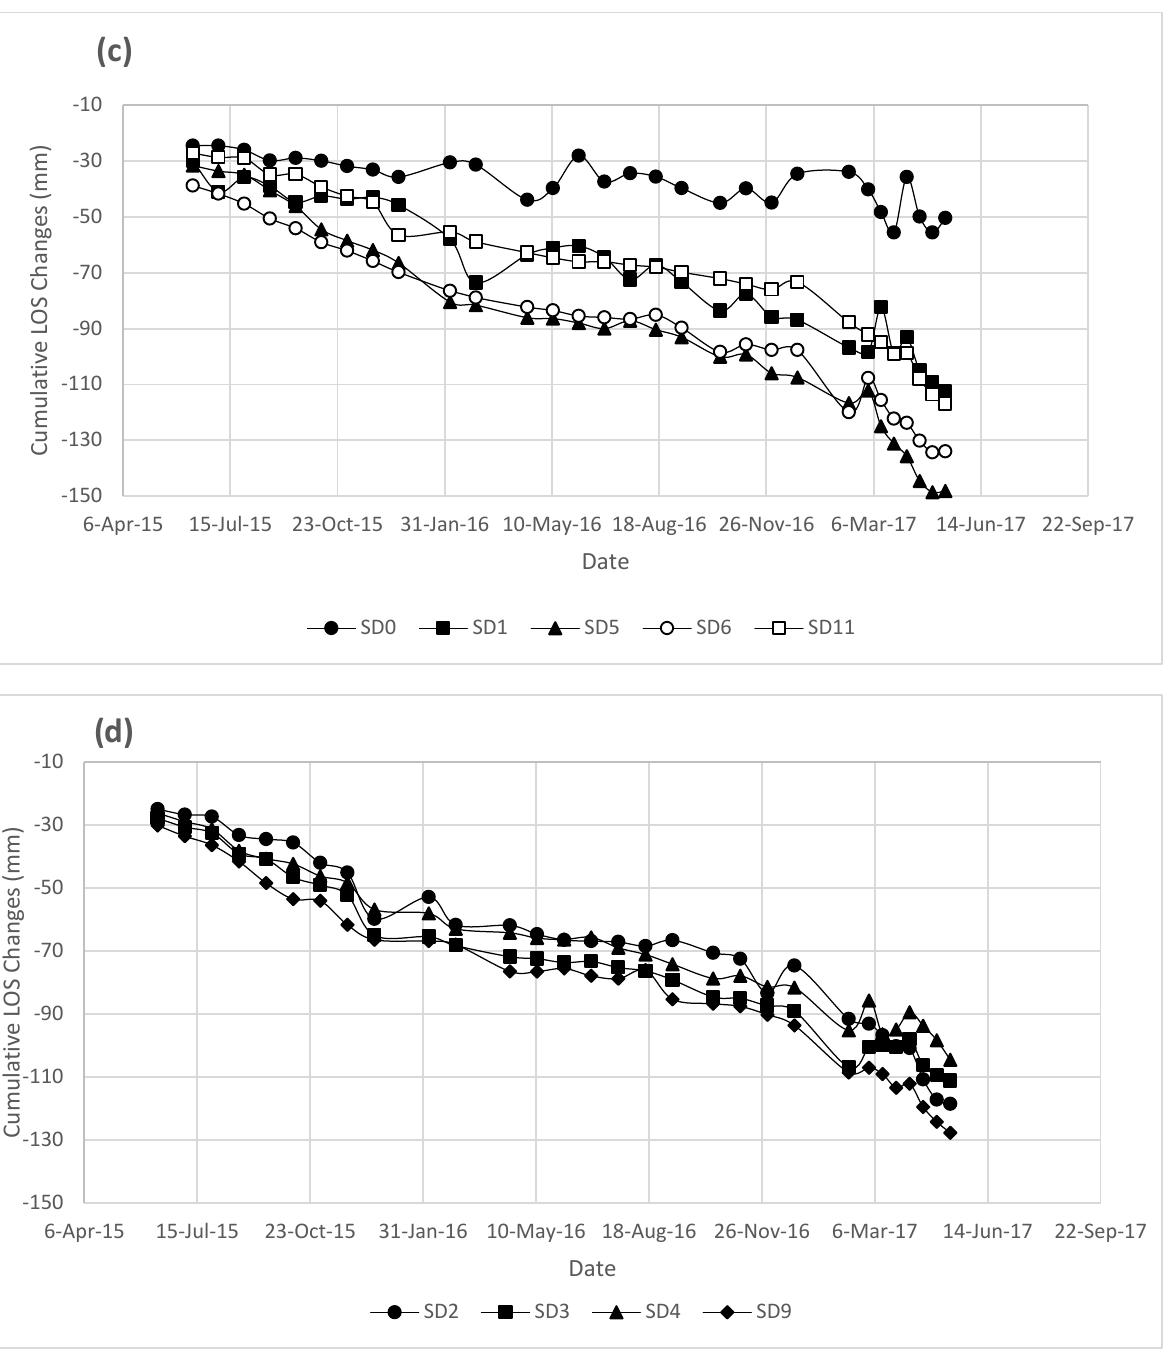
Figure 7. Average cumulative LOS displacement for both Sentinel ascending and Sentinel descending orbits for specific areas within the Ripley landslide (SA for Sentinel ascending and SD for Sentinel descending). ( a ) SA 0,1,5,6,7,8,10,11 and SD 7,8,10 – ( b ) SA 2,3,4,9,12,13,14,15 and SD 12,13,14,15 – ( c ) SD 2,3,4,9 – ( d ) SD 0,1,5,6,11.